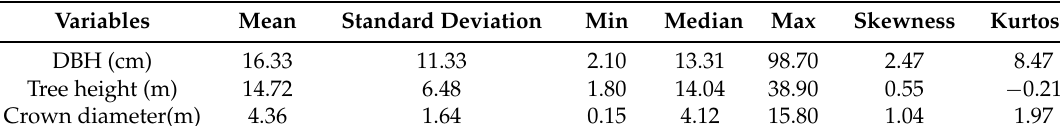
Table 1. Statistical results for the field measurements.